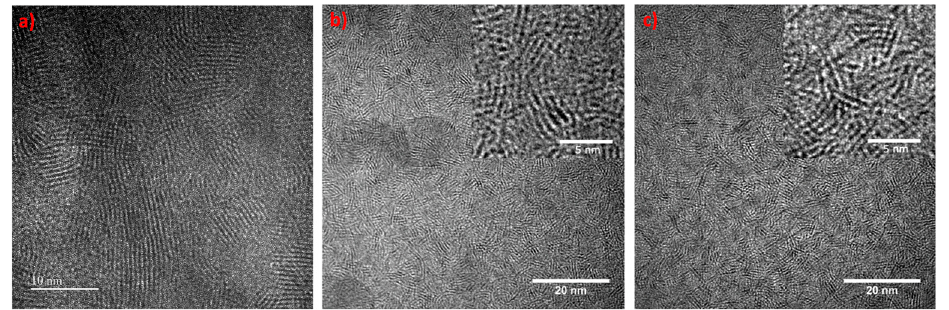
Figure 4. Transmission electron microscopy images of the ( a ) Pure MoSe 2 , ( b ) DC540 and ( c ) RF270 coatings.